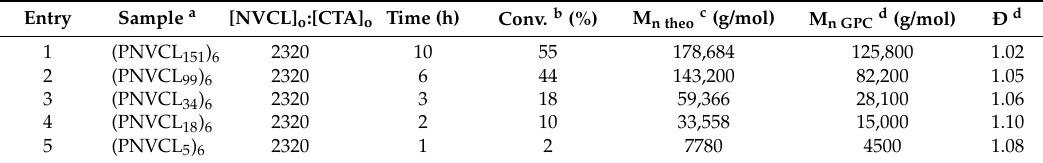
Table 1. Results for RAFT polymerization of NVCL in THF at 30 ◦ C in the presence of hexafunctional CTA-1 xanthate-type; PNVCL (poly( N -vinylcaprolactam); NVCL ( N -vinylcaprolactam); CTA-1